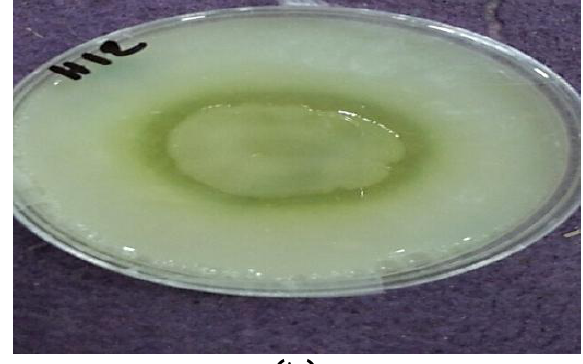
Figure, 3: (A) Phospholipase production. (B) Gelatinase production by Aeromonas